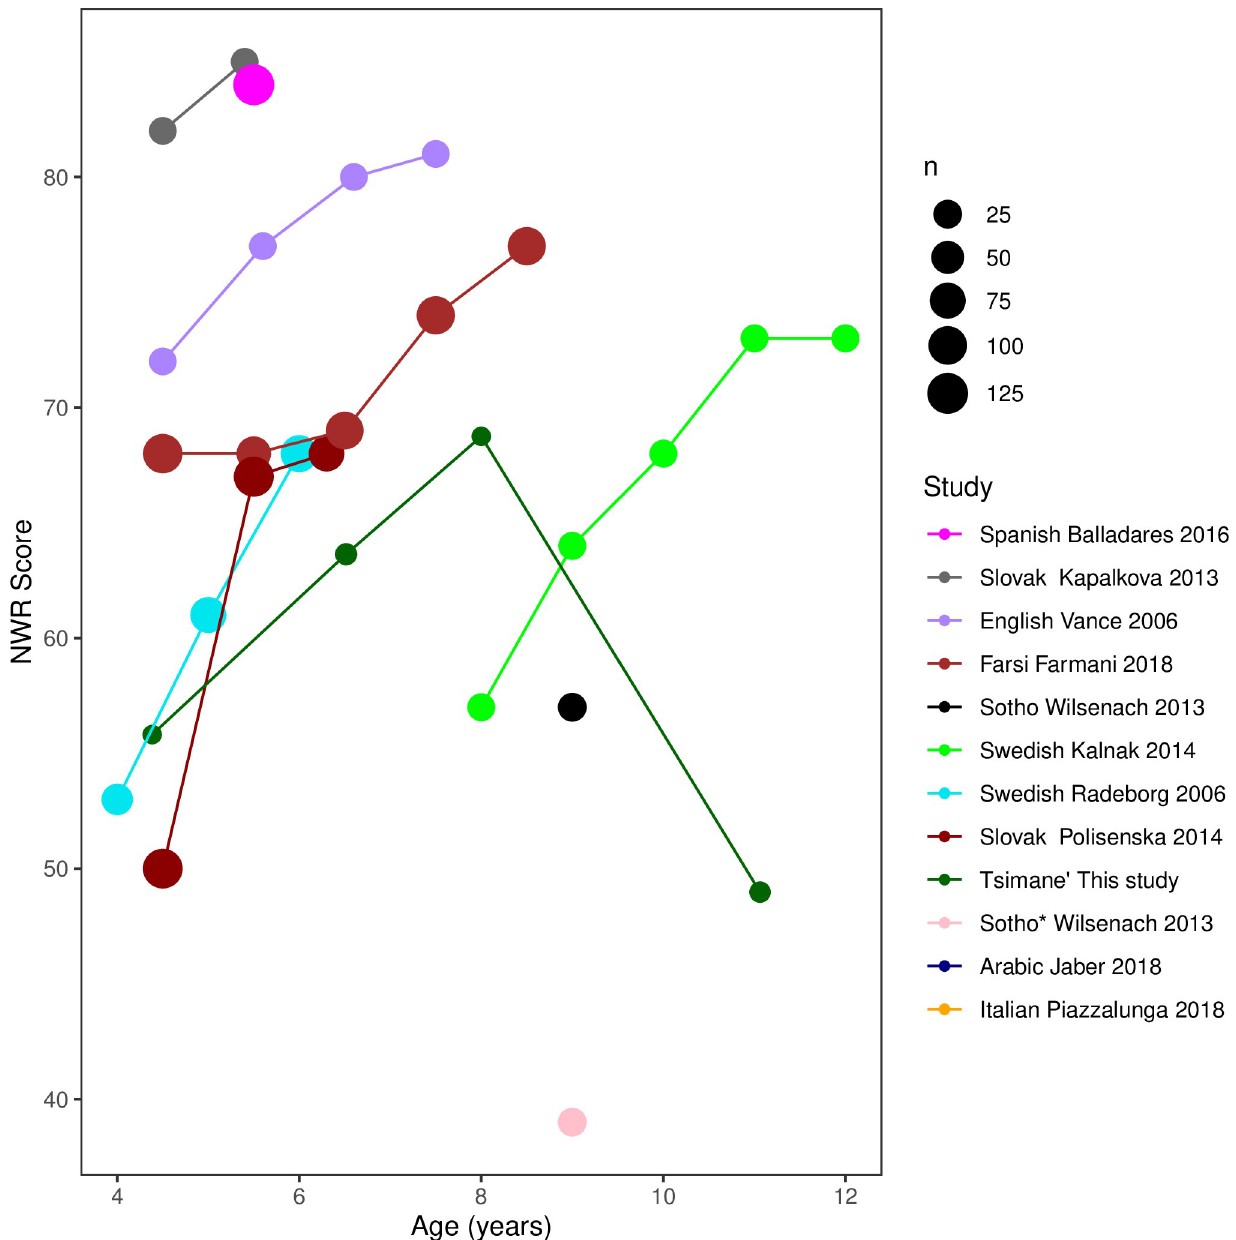
Fig 1. NWR scores as a function of age (in years), study (first author and year regardless of the number of authors). Study legend is sorted from highest to lowest average to facilitate linking. The size of the circle indicates sample